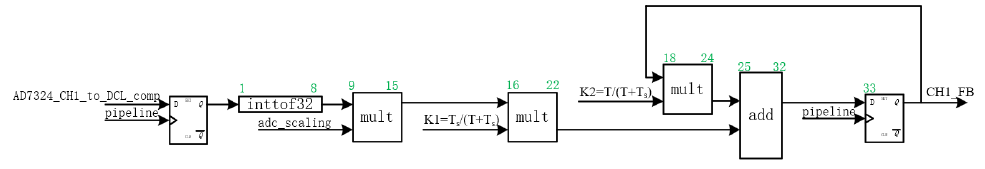
Figure 14. FPGA implementation diagram of low-pass filter pf.